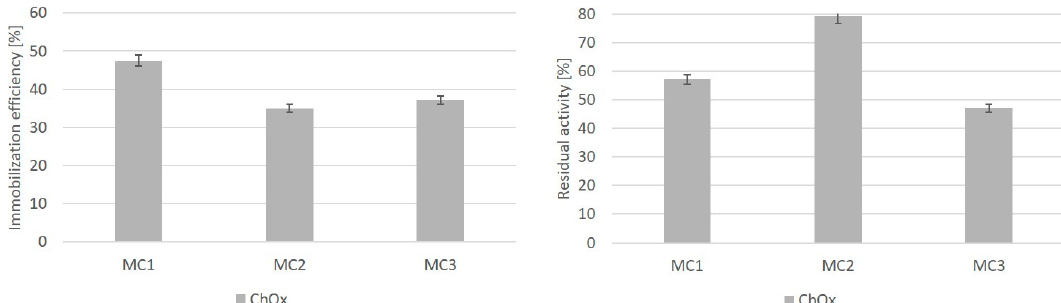
Figure 8. Immobilization e ffi ciency and residual activity of ChOx on di ff erent chitosan functionalized metal oxide micro- and nanoparticles with PEHA activation. Each column represents the mean of triplicate values, with the range indicated with error bars.